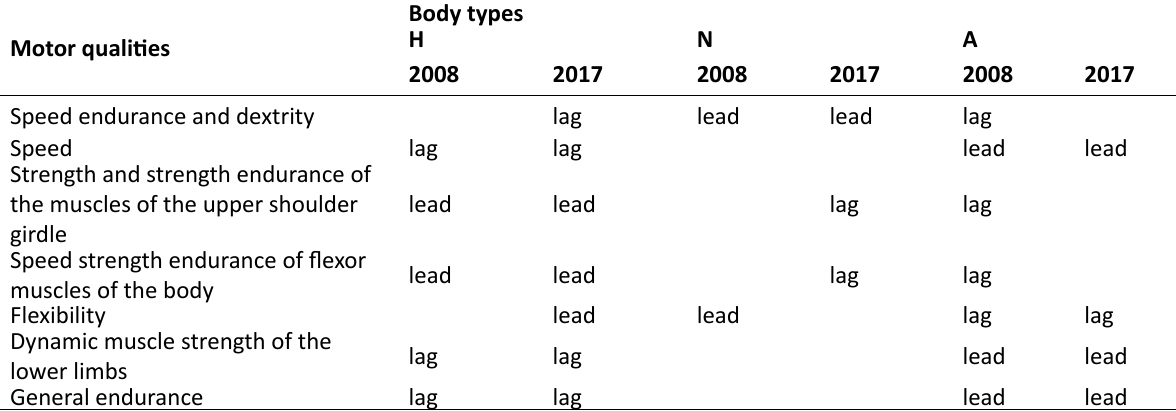
Table 3. Motor qualities priorities of young men of different generations with different body types from Baikal region